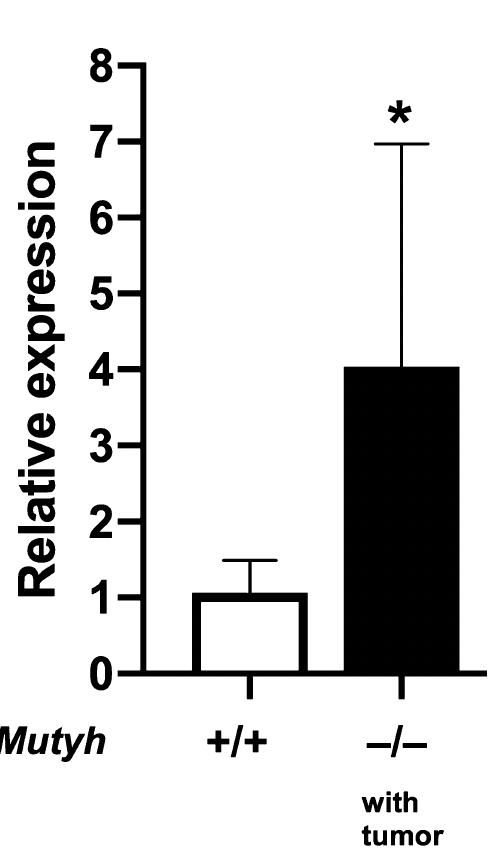
Figure 6. Expression of Myc mRNA in non-tumorous hepatic tissue of each groups evaluated by qRT-PCR. Increased Myc expression in non-tumorous hepatic tissue of MUTYH-null mice with an HFHC + high-iron diet with liver tumor. Data are the mean of five samples. Error bars represent the SD. * Indicates a significant change ( P =